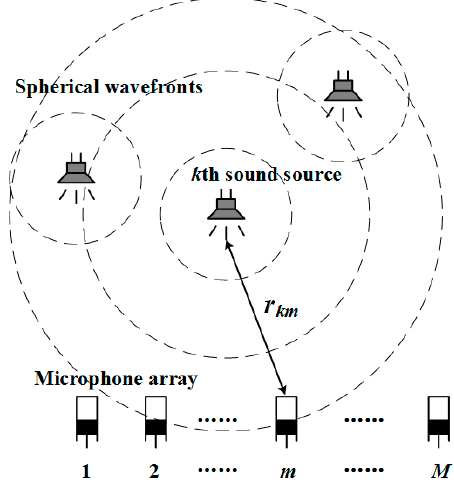
Figure 2. Spherical wave − front model.